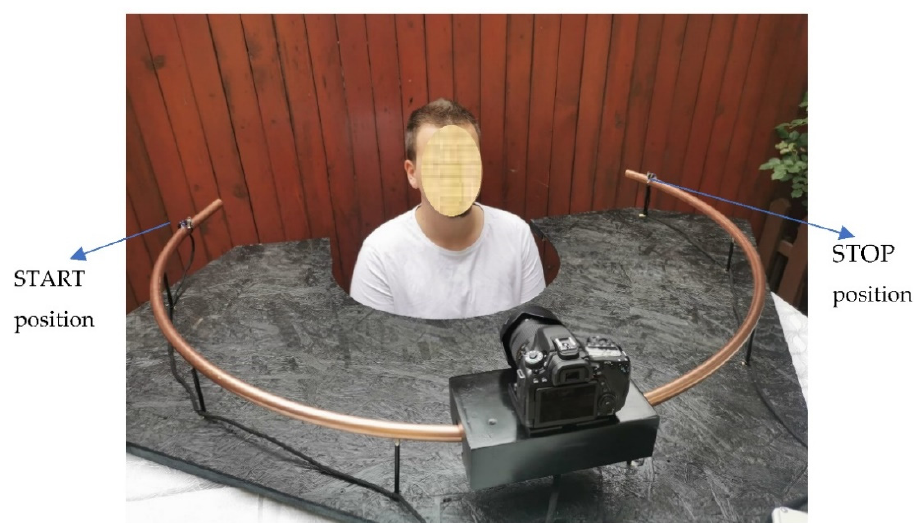
Figure 10. Process of human face scanning—between START and STOP positions.